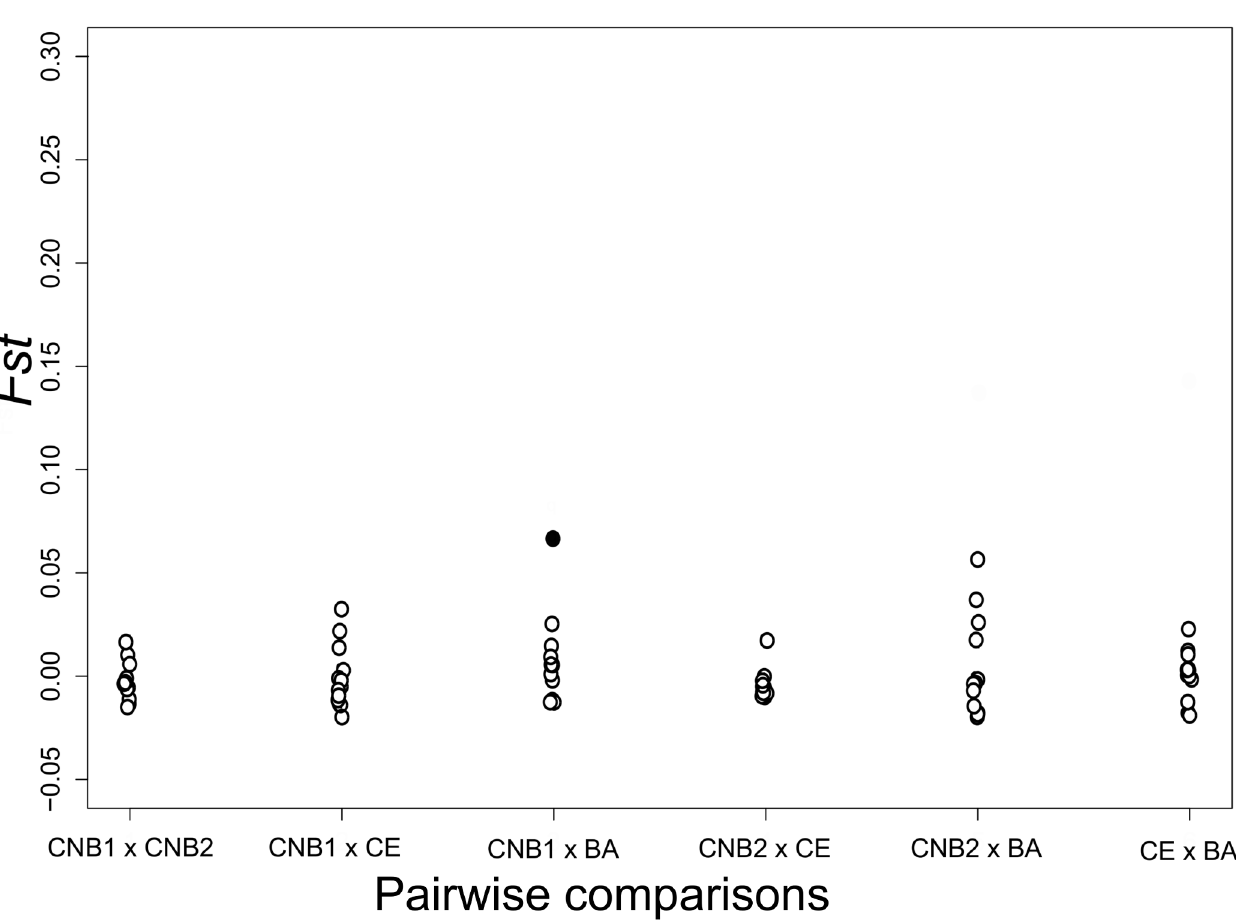
Fig 3. Comparisons of pairwise F ST between sampling locations and the loci used in this study. Open circles represent non-significant F ST after FDR correction ( i . e ., p > 0.02). Filled circles represent p < 0.02 (GH5).